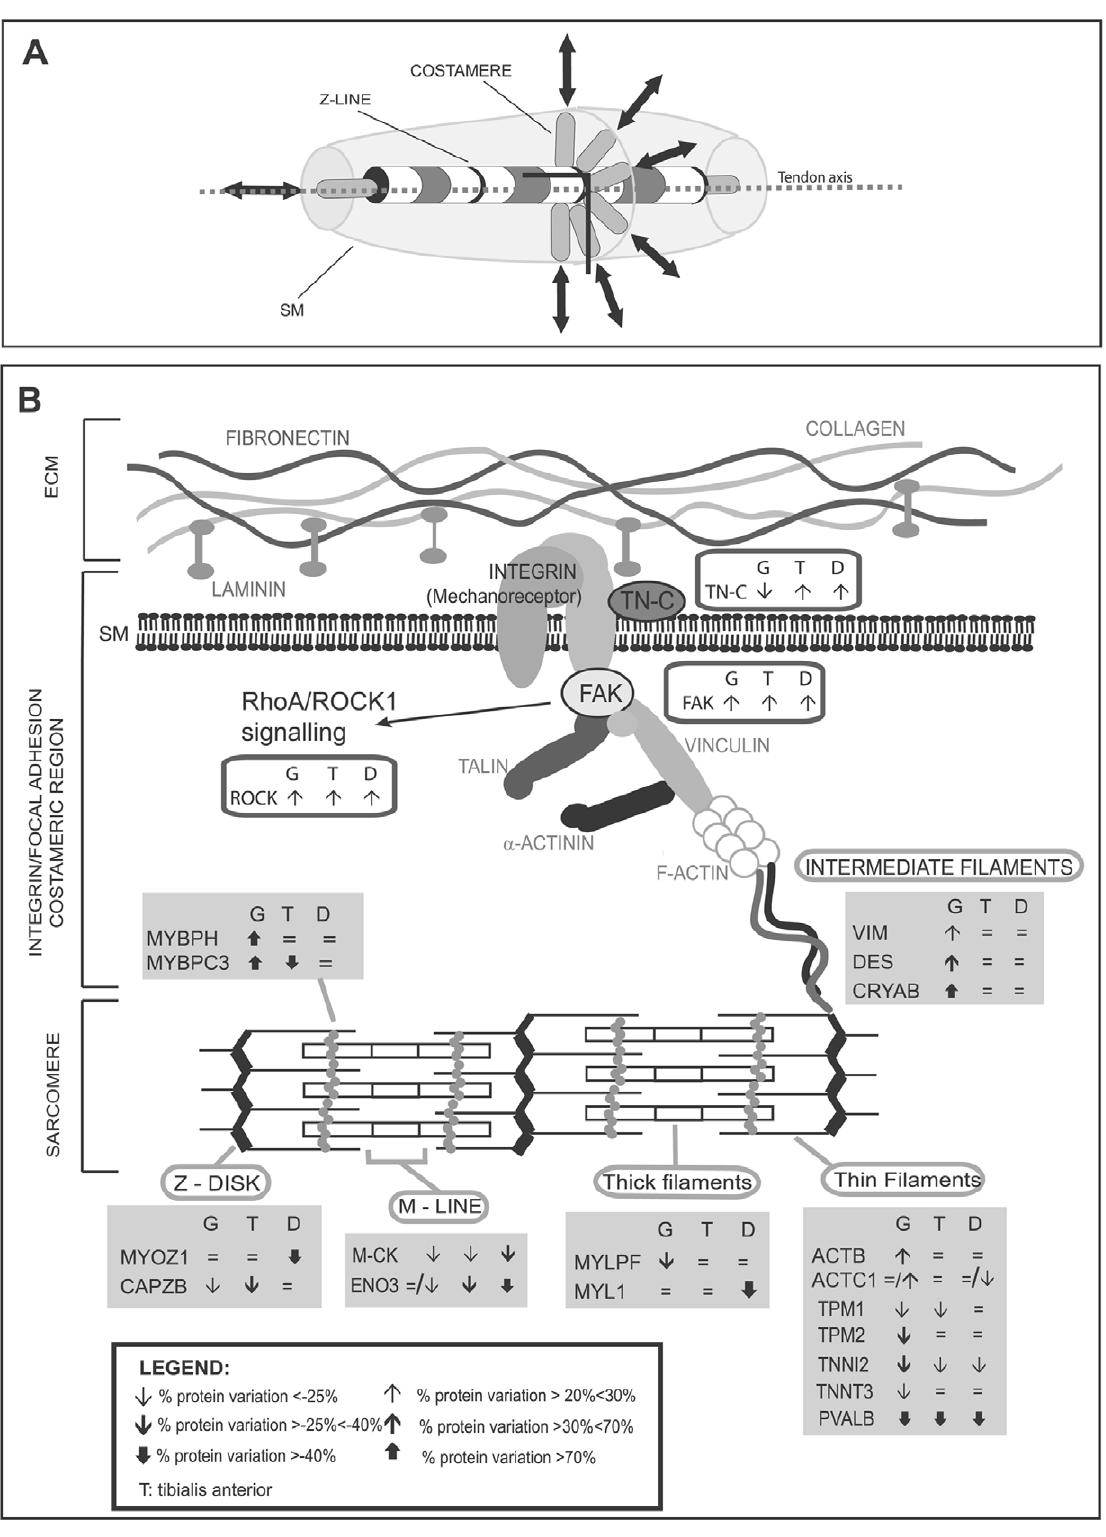
Figure 7. Costameric schematization, immunoblotting and proteomic results of proteins involved in mechanotransduction. Panel A: schematic representation of costameres and force transmission by ECM. The junction between cell matrix to the muscle cell is represented by costameres which consist of a complex protein network that forms a physical attachment of the underlying, outer Z discs of the muscle cell to its surrounding, stress-tolerant, ECM. These specialized sites occur over the entire sarcolemma, where the transmission of force is concentrated (black arrows) from cells to ECM, along and perpendicularly to the tendon axis (dotted grey line) with the role of keeping sarcolemma aligned with nearby contractile structures [79,80]. The absence of collagen VI would alter the signaling from the interstitial connective tissue to the muscle fiber and